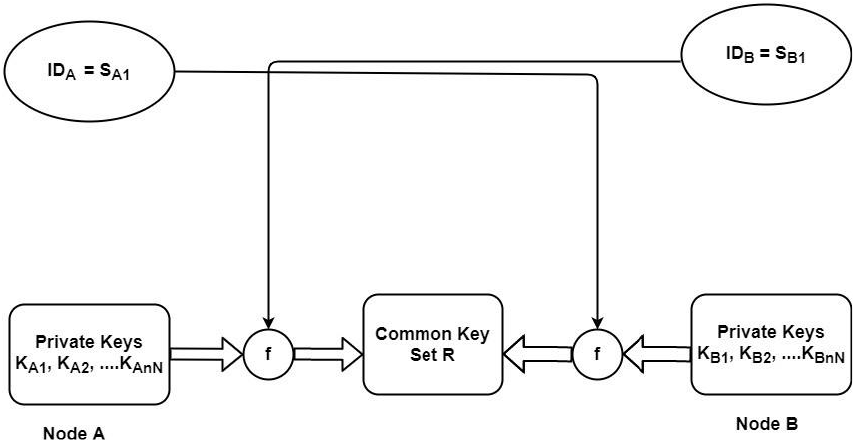
Figure 1. The BYka Process.